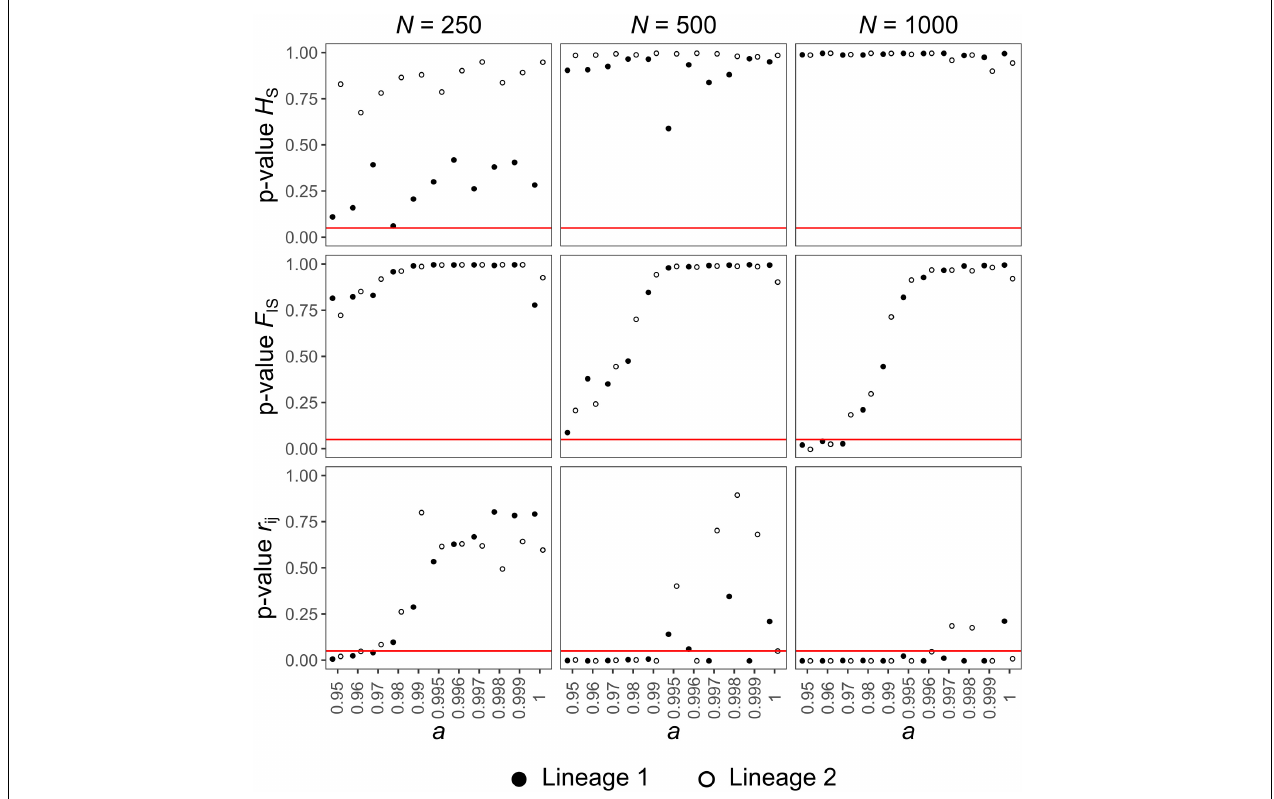
FIGURE 5 | Test of consistency of the C. mauritanica population genetic structure with respect to simulated data under varying parameters (rate of automixis: a and population size: N ), considering the population heterozygosity ( H S ), the individual inbreeding coefficient ( F IS ) and the distribution of pairwise relatedness coefficients between individuals ( r ij ) as test statistics. For each combination of simulated parameters, a p-value indicates whether the statistic of the empirical data departs significantly from the distribution of the statistic obtained by simulation (when the p-value is below the α threshold set to 0.05). Hybridogenetic lineages 1 (black dots) and 2 (white dots) were analyzed separately. Three population sizes were investigated: N = 250, 500, and 1000. Simulated data were generated without migration ( m = 0). The red line corresponds to the α threshold